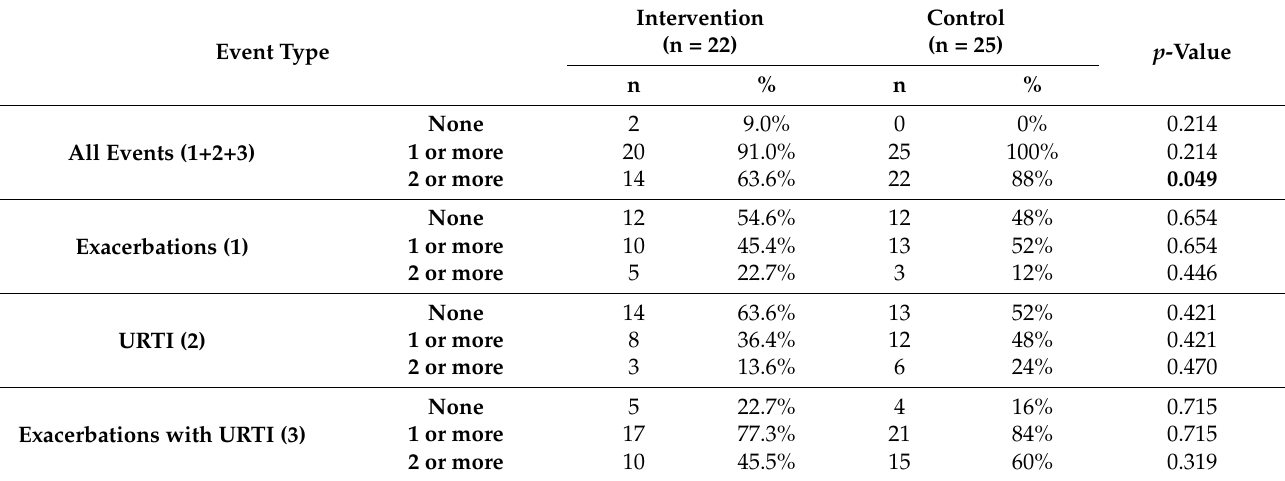
Table 3. Frequency of asthma exacerbations and upper respiratory tract infections reported by parent during the 6-month intervention